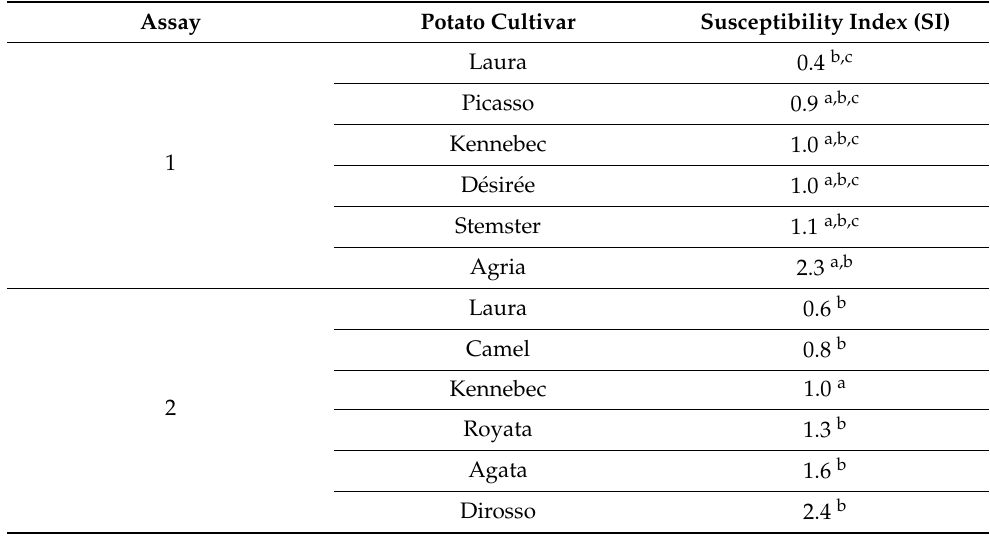
Table 1. Susceptibility index (SI) of potato cultivars 60 days after inoculation with 8000 Pratylenchus penetrans mixed stages. SI followed by different combination of letters differ significantly at p < 0.05, according to the Fisher LSD